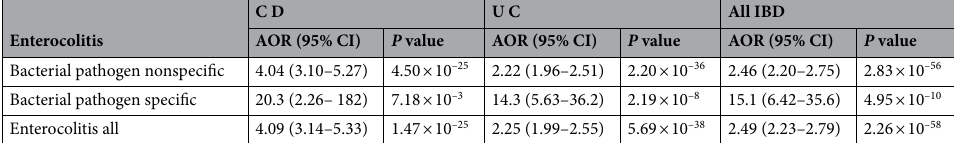
Table 5. AORs and 95% CIs using logistic regression analysis, enterocolitis.